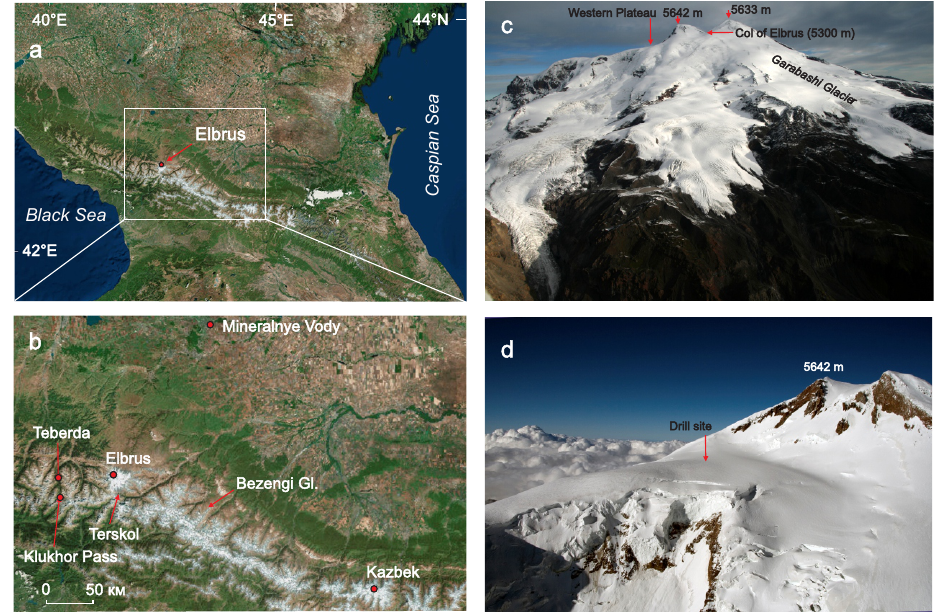
Figure 1. Location of study area: (a) Mt. Elbrus in the Caucasus; (b) glaciers and meteorological stations; (c) Mt. Elbrus from the south demonstrating the position of the western plateau; (d) western Elbrus plateau drill site (photos by I. Lavrentiev, September 2009). ArcGIS World Imagery Basemap used as the background. Source: